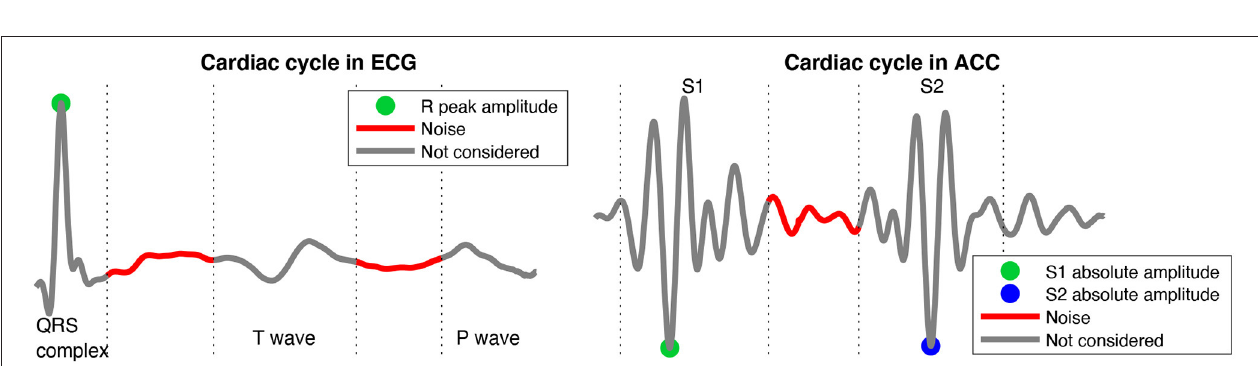
FIGURE 5 | Representation of the signal of interest and noise segments of the cardiac cycle in the ECG and ACC signals to compute the